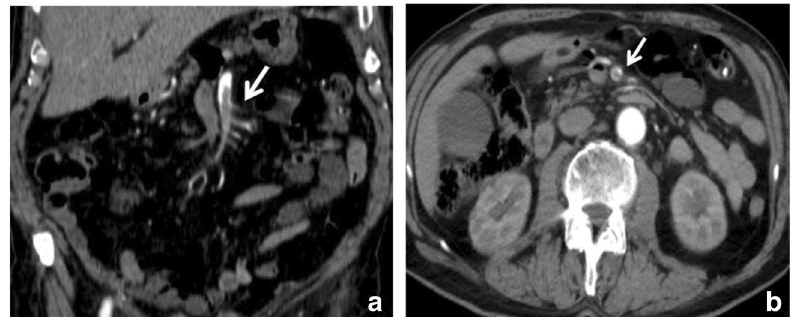
Fig. 2 Arterial occlusion.